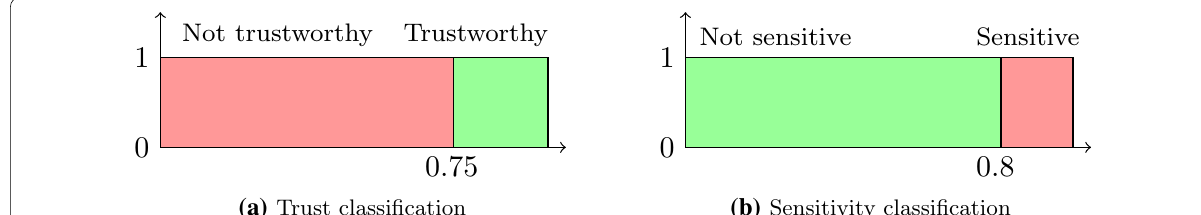
Fig. 1 Binary view of considering user trustworthiness and object sensitivity